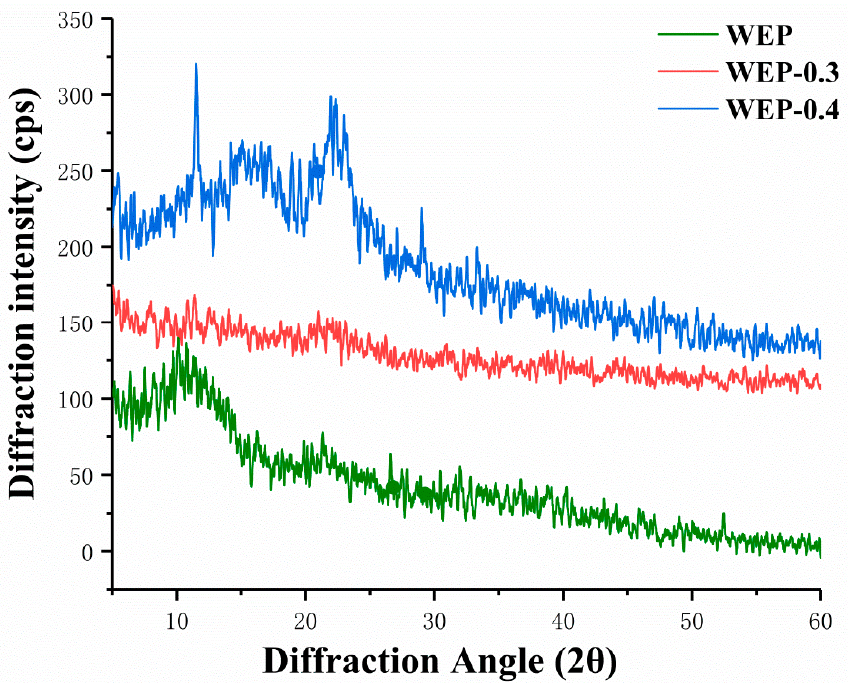
Figure 3. X-ray diffraction patterns of WEP and its fractions. ( a ) WEP; ( b ) WEP-0.3; ( c )